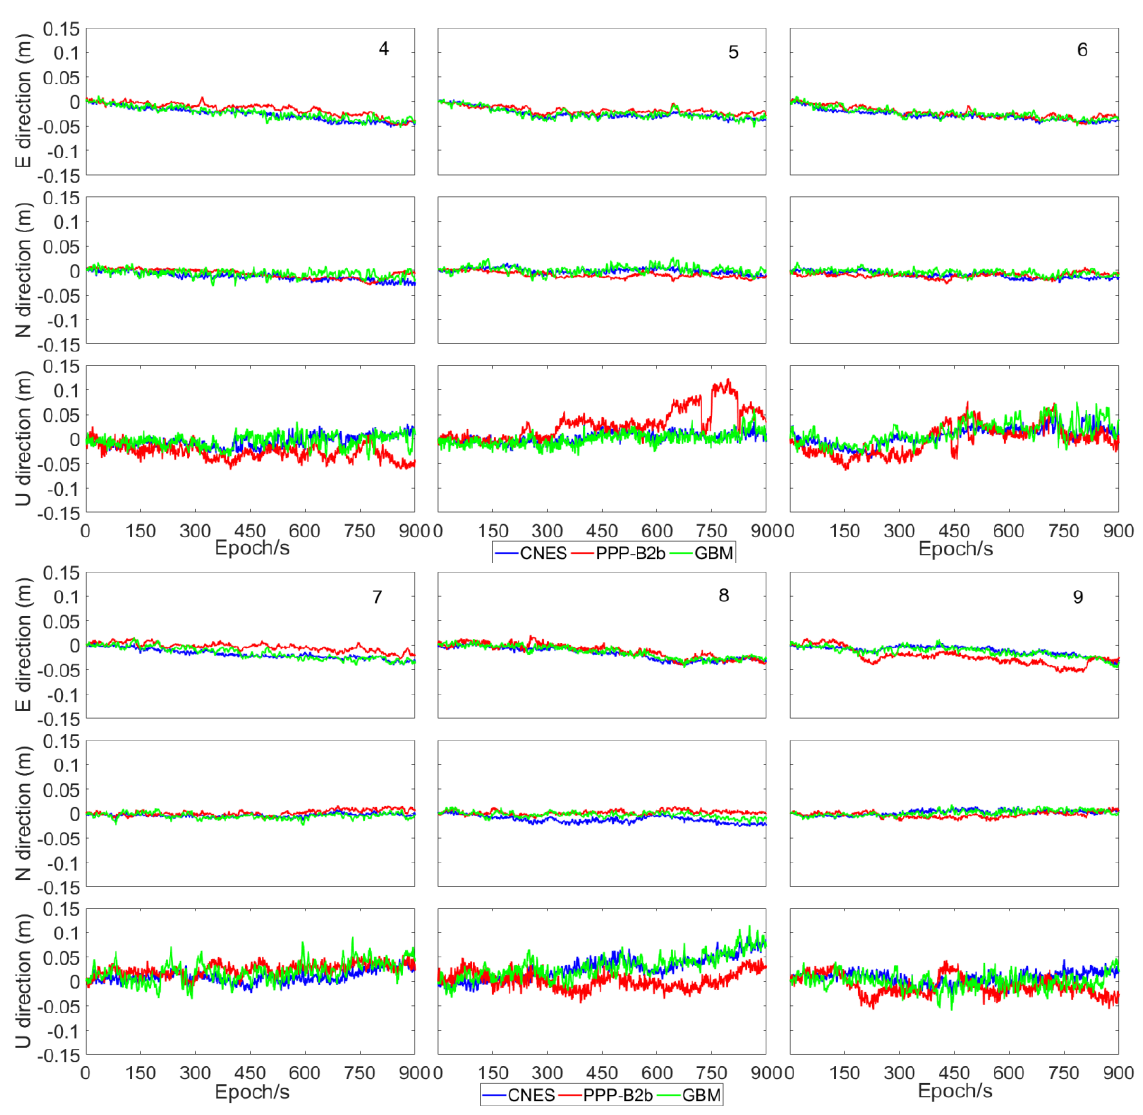
Figure 15. Positioning errors in nine sets of experiments at WHU2 station.